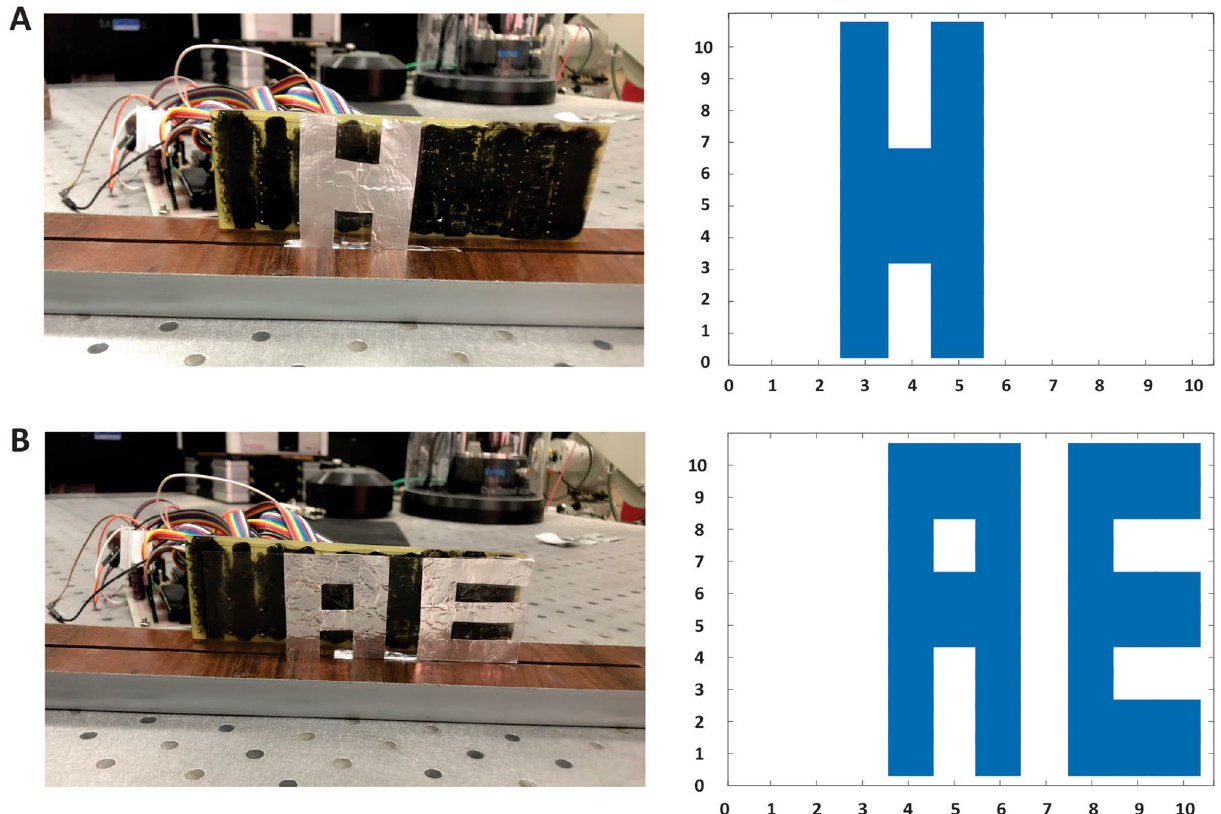
Figure 7. The image of different logos are constructed by the IR camera and displayed on the monitor. The images of the ( A ) H and ( B ) AE logos obtained by the proposed IR camera.